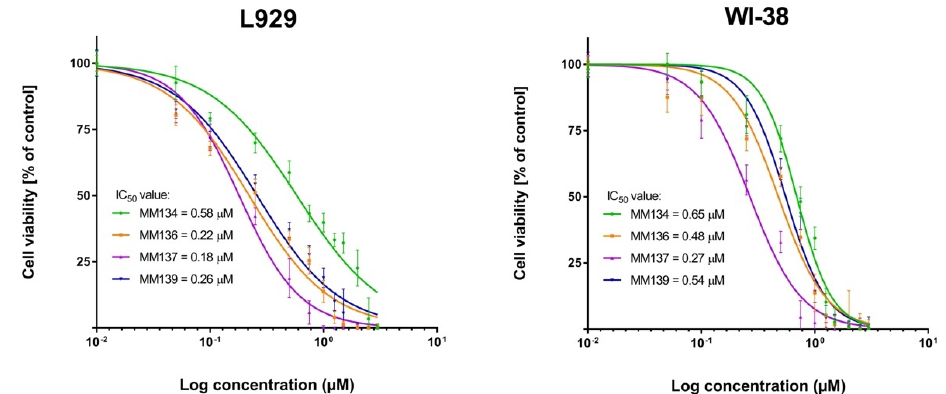
Figure 5. Determination of relative cell viability of mouse fibroblast cell line (L929) and human normal fibroblast cell line (WI-38) treated with MM-compounds; ± SEM.